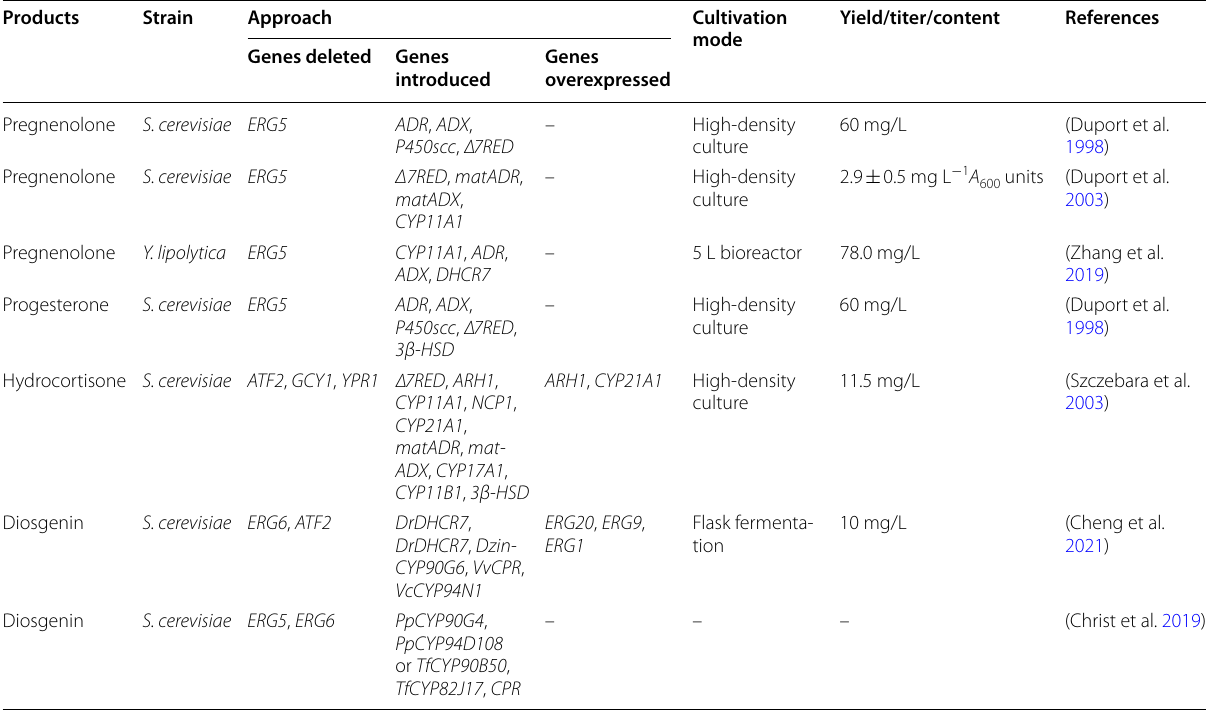
Table 2 De novo synthesis of typical steroids in